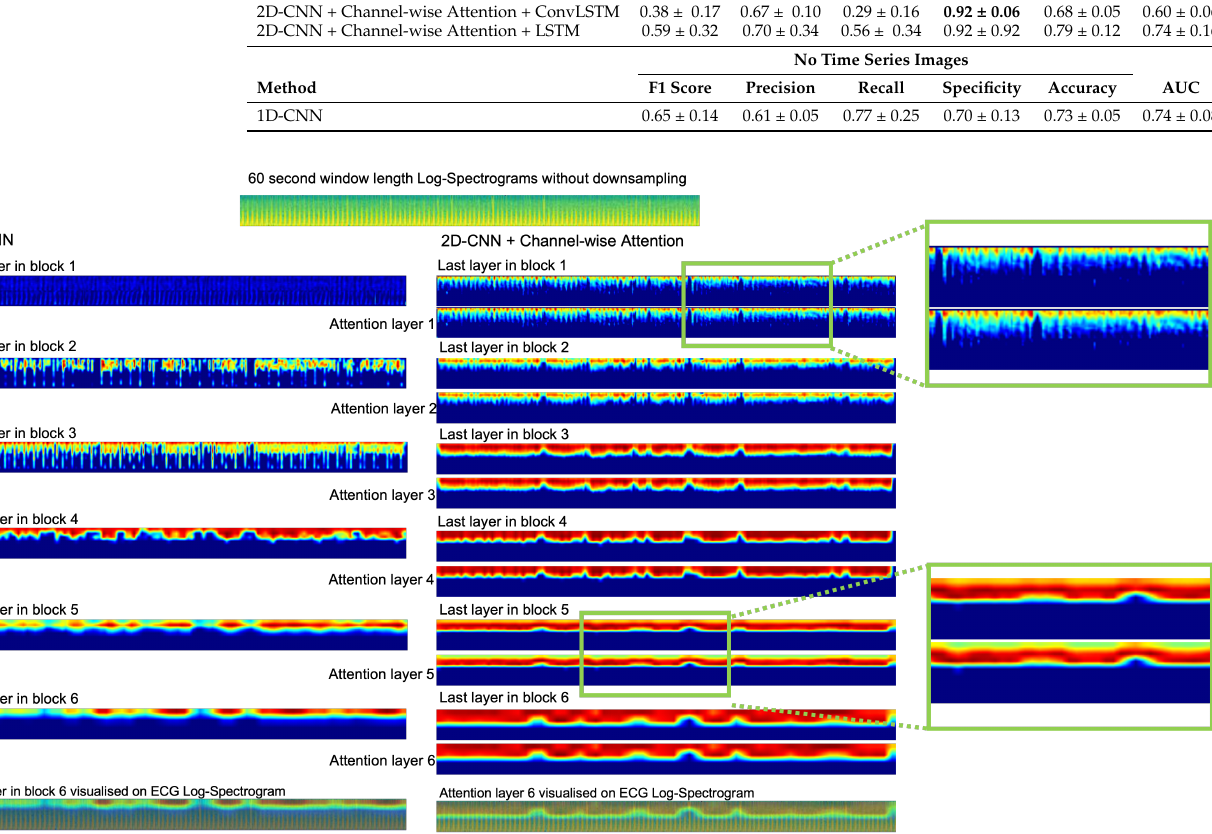
Figure 6. Examples of visual explanations of the features in all different layers of the baseline 2D-CNN method and the proposed 2D-CNN + Channel-wise Attention method. The 60-s window length log-spectrogram of raw ECG data is the input of these two methods. The green rectangle highlights the huge visual difference between the adjacent layers in the proposed